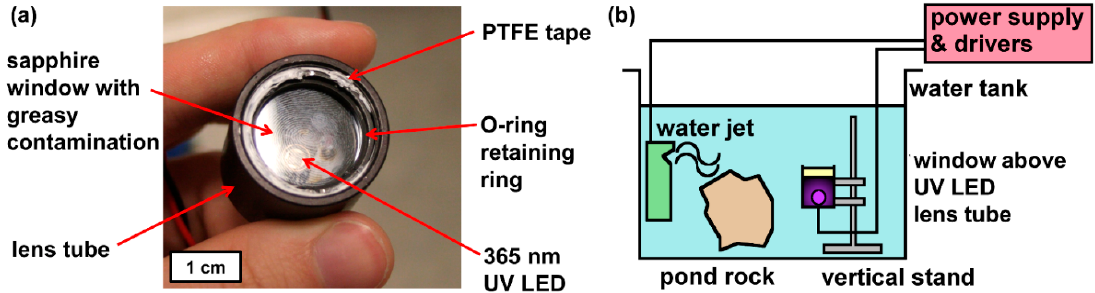
Figure 1. ( a ) Annotated photograph of submergence lens tube set-up. ( b ) Schematic of the tank set- up (note: pond rock only present for biofouling tests to ensure rich bioactivity in pond